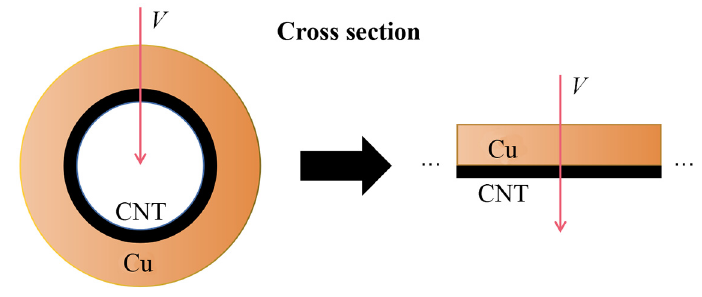
Figure 8. The structure model diagram of the CNT–Cu composite.